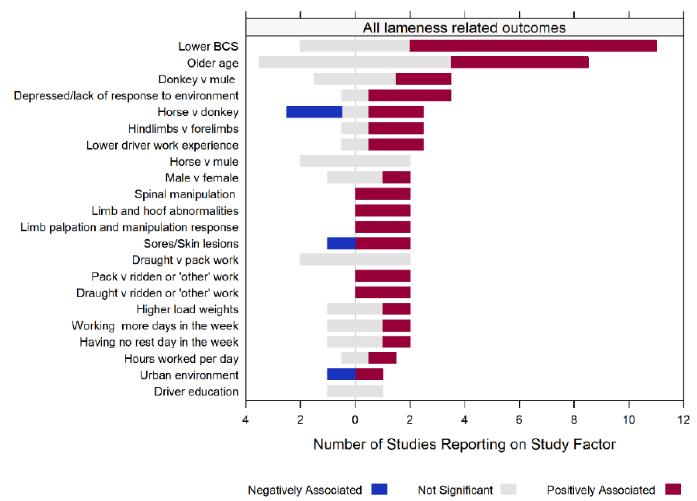
Figure 4. Summary of study factors for all lameness-related outcomes (prevalence of lameness, prevalence of gait abnormality, or lameness scores combined) reported by more than one study in a systematic review of studies investigating working equid lameness in low- and middle-income countries ranging from 2003 to 2021. For binary study factors, the reference category is listed last. The direction of associations reported is represented by different colours, with positively associated factors being those associated with a higher prevalence or severity of a lameness-related outcome, and negatively associated factors being those related to a lower outcome prevalence or grade. Each study contributes only once to each factor as the overall study population. Significance levels and directions of study factors for different study arms are not represented in this figure and may differ from that extracted for the overall study population.